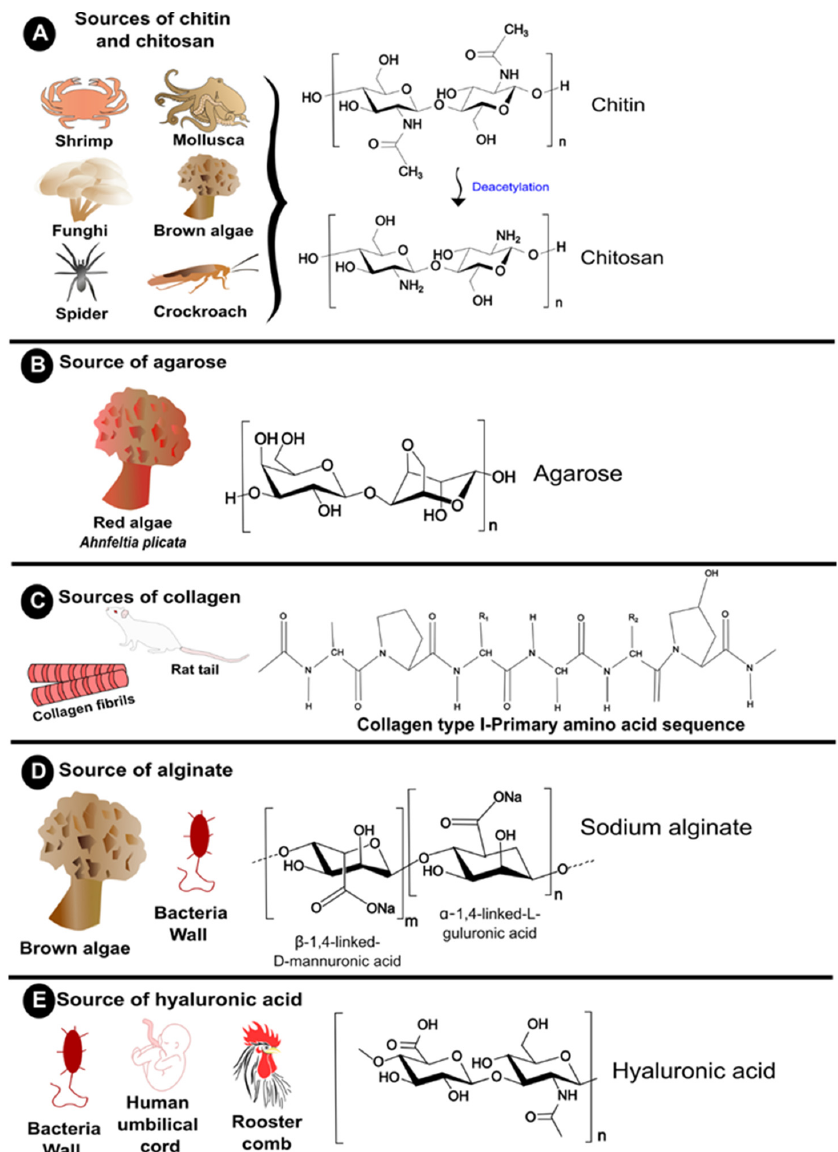
Figure 2. Schematic figure concerning the main source of the most frequently employed biopolymers for cells microencapsulation and their polymer structures. ( A ) Chitin and chitosan. ( B ) Agarose. ( C ) Collagen. ( D ) Alginate. ( E ) Hyaluronic